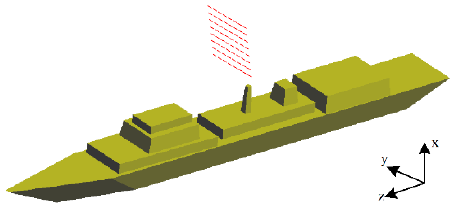
Figure 6. Illustration of shipborne array antenna.